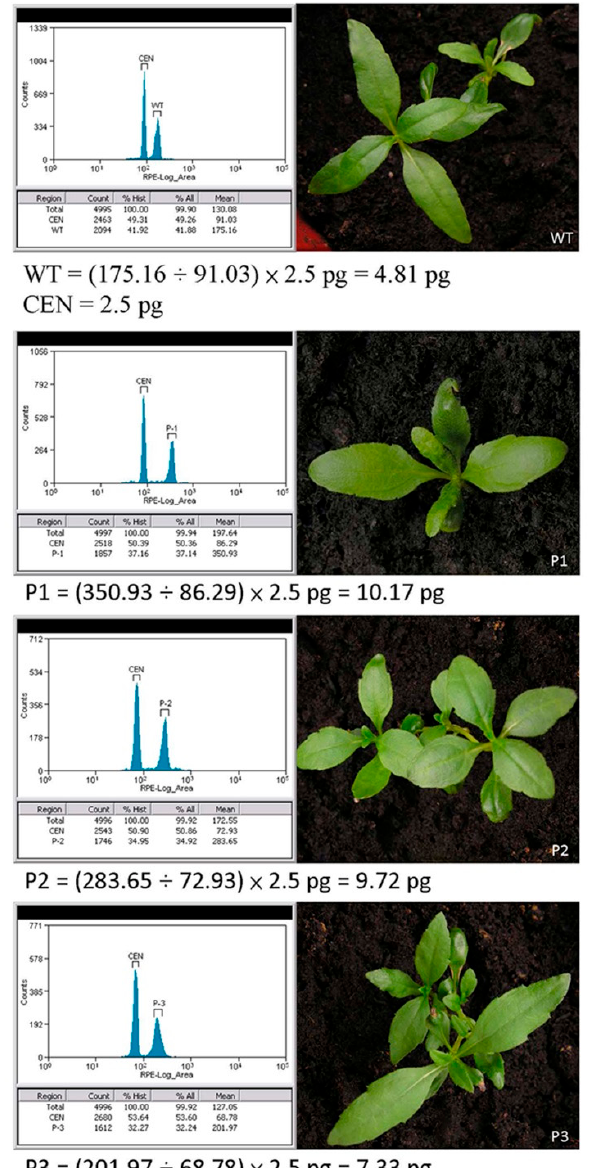
Figure 3. Flow cytometry analysis of selected polyploid plants from Wedelia chinensis . Detection of genome size (2C) in diploid (WT), triploid (P3) and tetraploid (P1, P2) plantlets by flow cytometry analysis. CEN represents chicken erythrocyte nuclei. The published genome size of CEN is 2.5 pg.